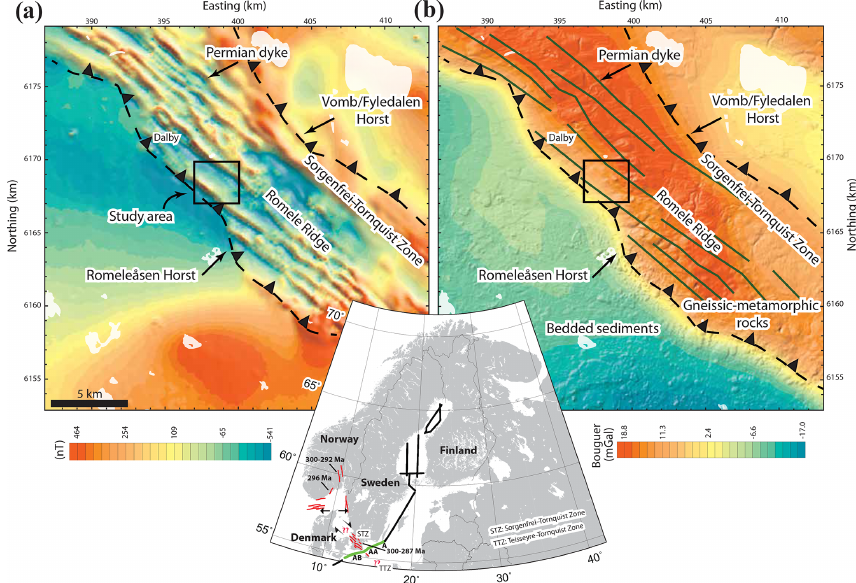
Figure 1. (a) Aeromagnetic anomaly and (b) bouguer gravity maps of the Scania region of Sweden showing the location of the study area south of the town of Dalby. Magnetic lineaments clearly mark the location of Permian dyke swarms within the Sorgenfrei–Tornquist Zone (STZ), which is a horst structure within an active strike-slip tectonic setting. The inset map shows the interpreted location of the dyke swarms of the same generation within the STZ. Dyke orientations and ages are based on Phillips et al. (2017, and references therein). In this work, historical offshore BABEL (Baltic and Bothnian Echoes from the Lithosphere) lines A-AA-AB (green lines in the inset map) have also been revisited and results discussed. Aeromagnetic and gravity data were kindly provided by the Geological Survey of